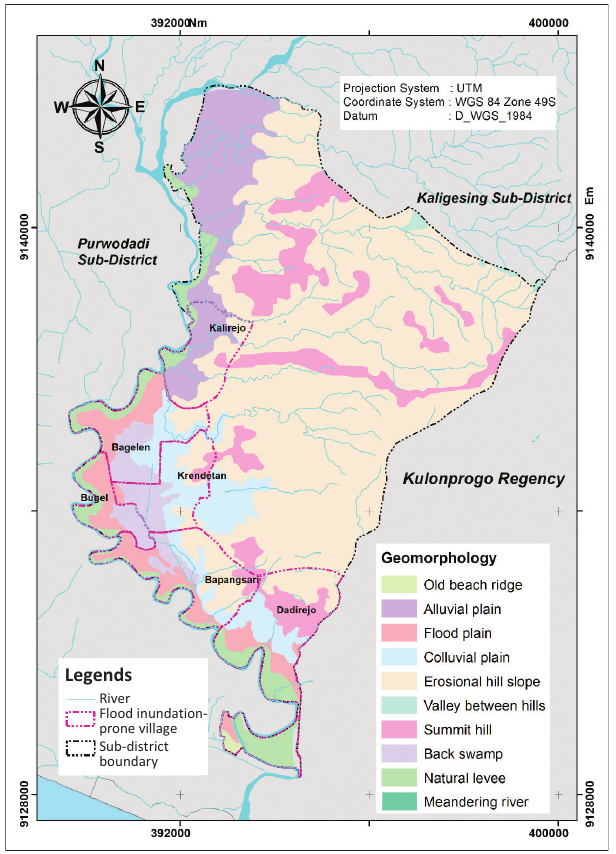
FIGURE 1: Geomorphology and flood inundation-prone villages of the Bagelen subdistrict (Mei 2008).